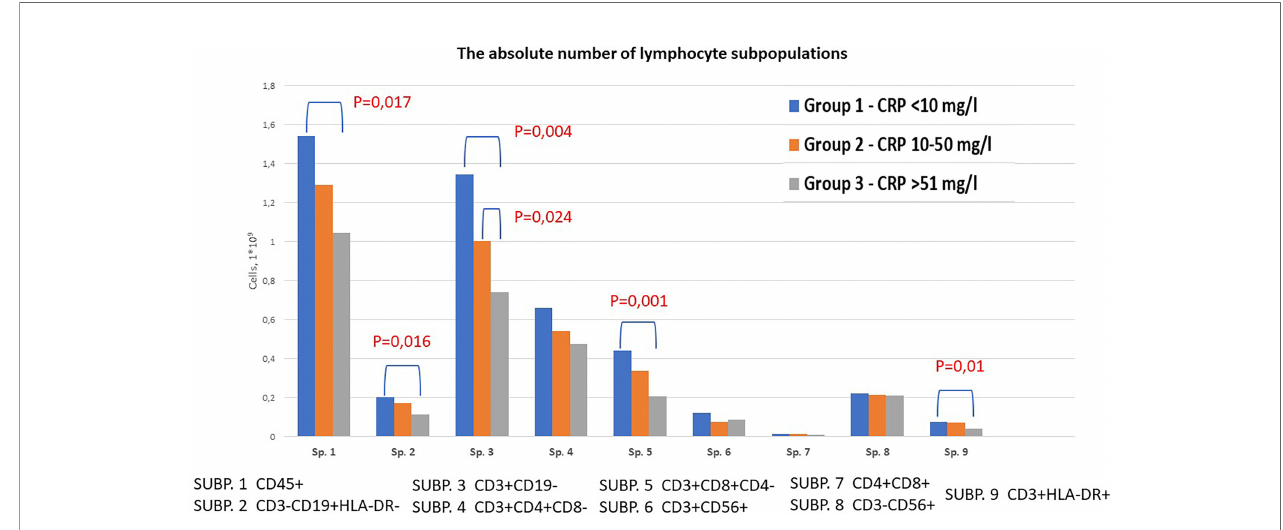
FIGURE 1 | Content of lymphocyte subpopulations depending on CRP levels in patients with COVID-19. Venous blood out of 43 patients was analyzed using fl ow cytometry to identify SUBP1 – total lymphocytes (CD45 bright), SUBP2 - B-cells (CD3-CD19+), SUBP3 - T-cells (CD3+CD19-), SUBP4 - T-helpers (CD3+CD4+CD8-), SUBP5 - T-cytotoxic (CD3+CD8+CD4-), SUBP6 - T-NK cells (CD3+CD56+), SUBP7 - double positive T-lymphocytes (CD4+CD8+), SUBP8 - True natural killer cells (CD3-CD56+), SUBP9 - activated T cells (CD3+HLA-DR+). COVID-19 patients were divided in 3 groups according to the CRP levels: group 1 <10 mg/l; group 2 10-50 mg/l; group 3 >50 mg/l. Statistical analysis was carried out using Mann-Whitney